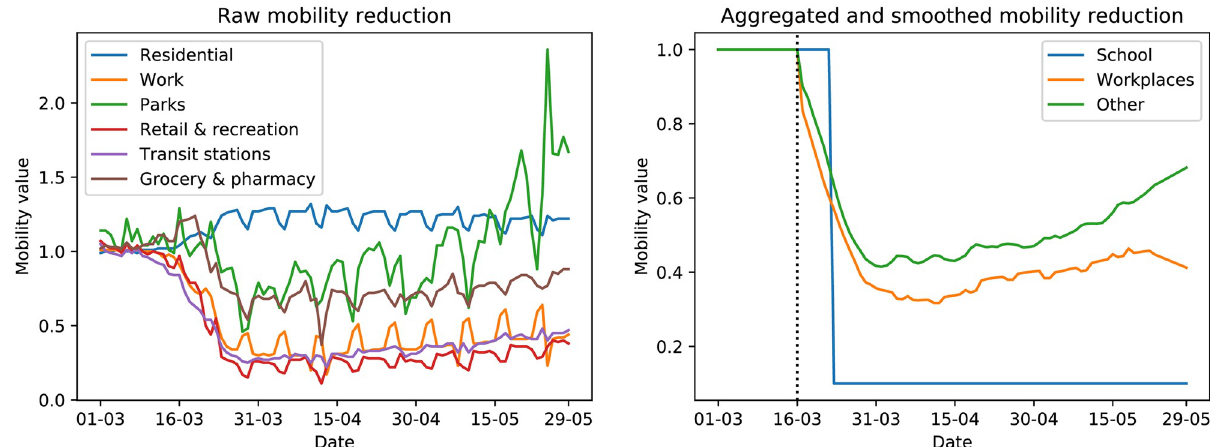
Fig 4. Raw and elaborated mobility data in the UK. In the raw mobility data, which is scaled with respect to a baseline value representing average mobility in the months prior to the pandemics, a strong weekly seasonality is present, which we mostly removed using a Savitzky–Golay filter. Moreover, we note that the mobility towards “residential” (which is not used in our analysis) locations is larger during the lockdown months than before, as people spend more time in their homes. Finally, we note the very large increase in people’s mobility towards parks around the end of the winter season. That contribution is however only one of the components in our aggregated m other mobility value, so the latter does not increase that abruptly.